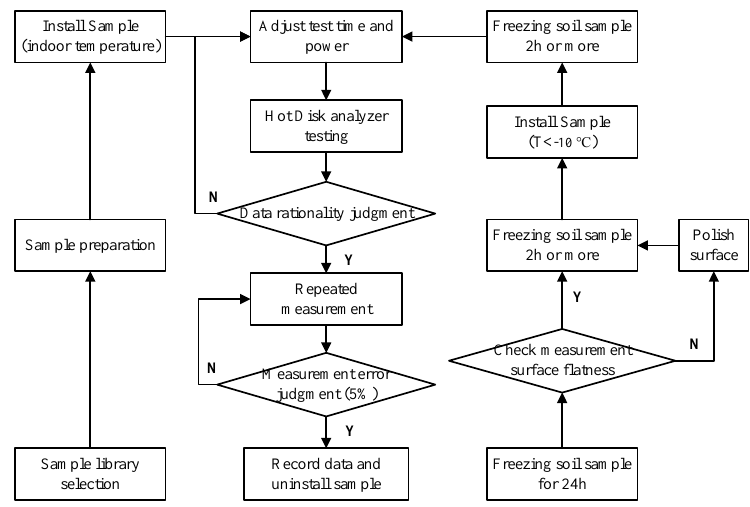
Figure 4. Flow diagram of thermal conductivity test.